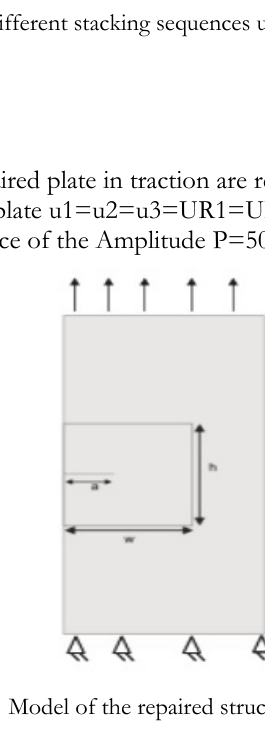
Figure 3 : Model of the repaired structure under